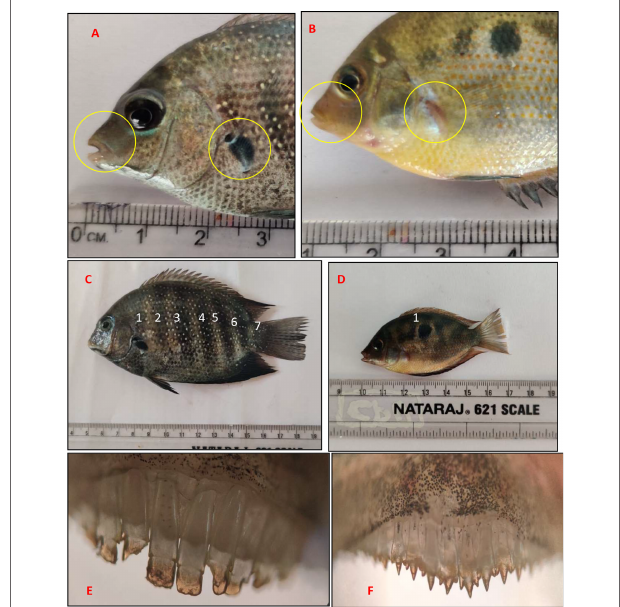
FIGURE 1 | Key identification points for P. maculatus in comparison with E suratensis (A) E suratensis with blunt snout with a steeply sloping profile; a prominent black patch on the pectoral fin (B) P. maculatus with snout profile markedly acute; pectoral fin hyaline. (C) E suratensis with seven prominent dark lateral bars (D) an absence of bars but the presence of one or more black blotches on the side of the body in P. maculatus. (E) Lateral oral dentition unicuspid, spatulate in E suratensis (F) Tricuspid in P. maculatus.